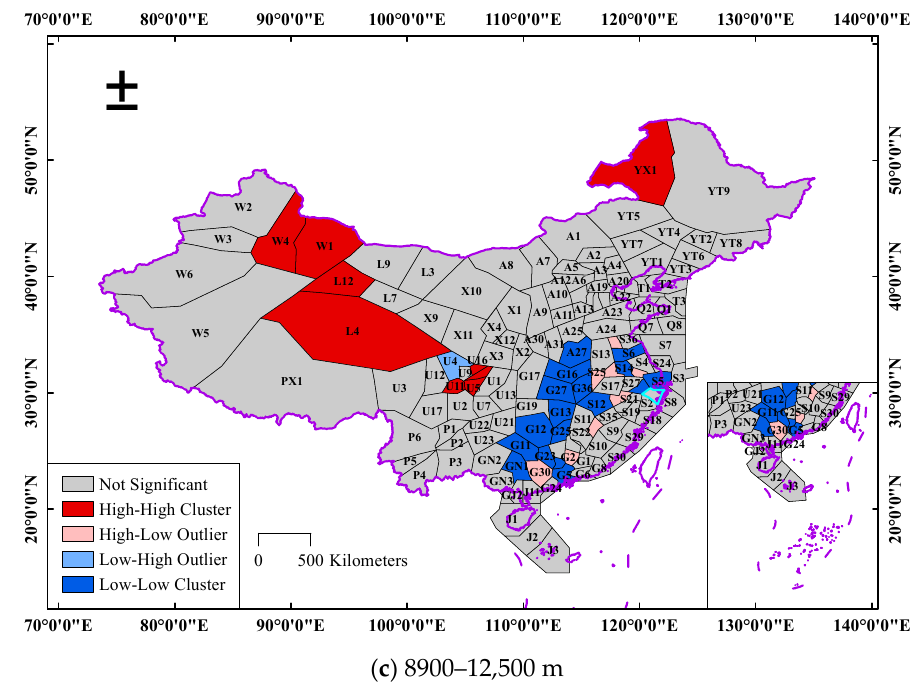
Figure 9. LISA agglomeration graph of FSRA in Chinese airspace.